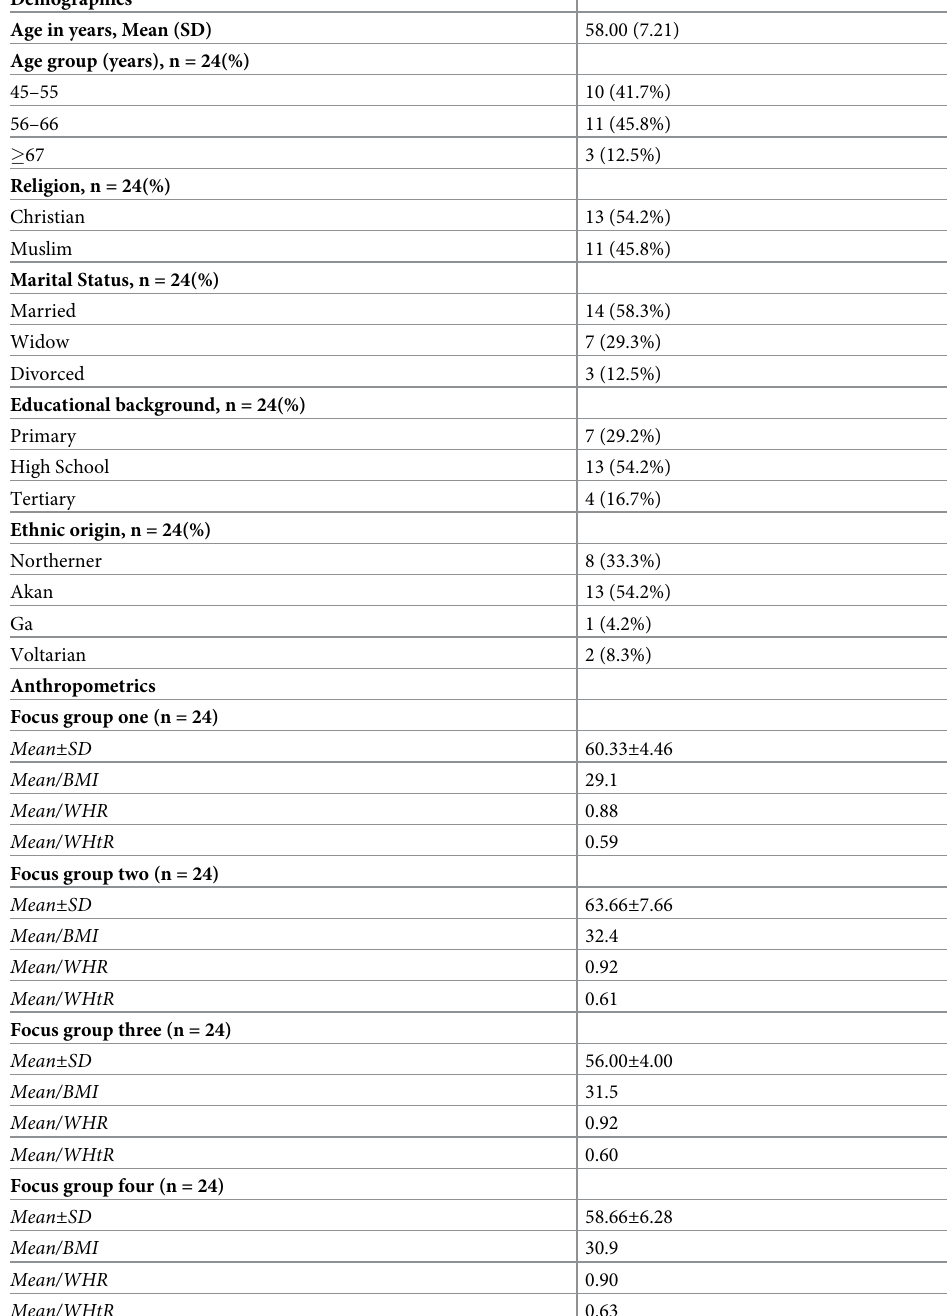
Table 1. Demographic information of